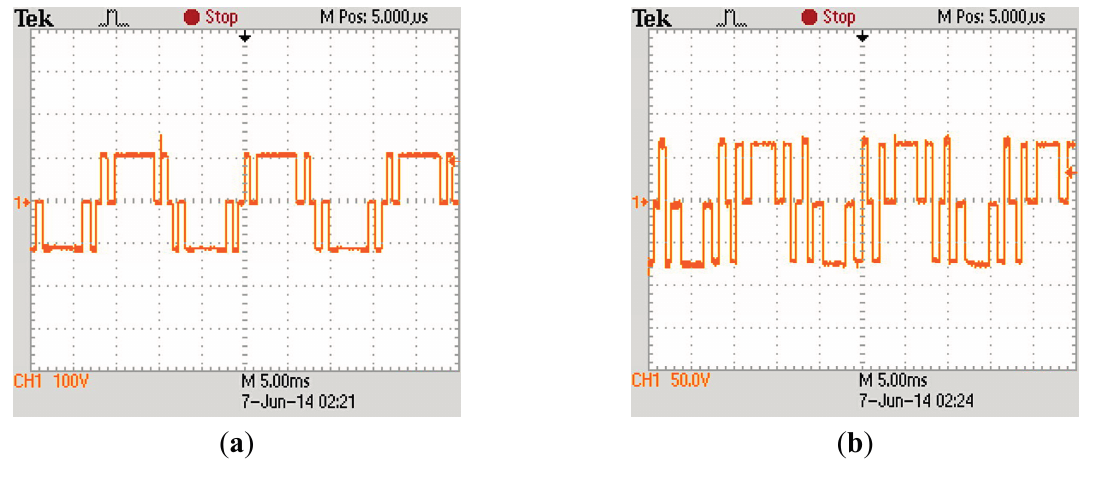
Figure 13. Independent H-bridge voltages ( a ) V H 1 ; ( b ) V H 2 .